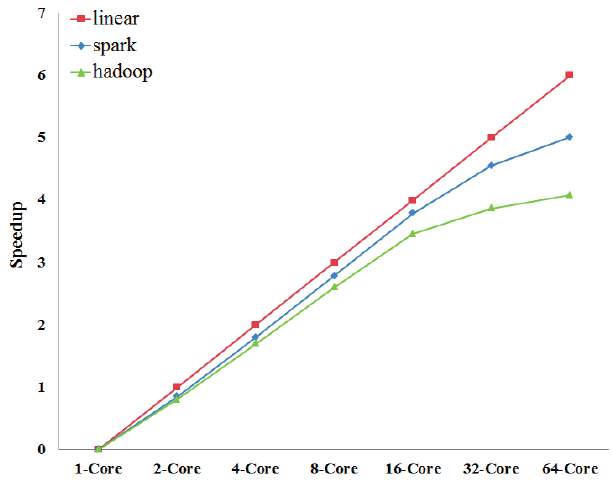
Figure 4. Comparison between the speedups of Spark and Hadoop. In order to make the linear speedup to be a straight line, we let y = log 2 ( T 1 / T n ). T 1 is the running time of common program (single